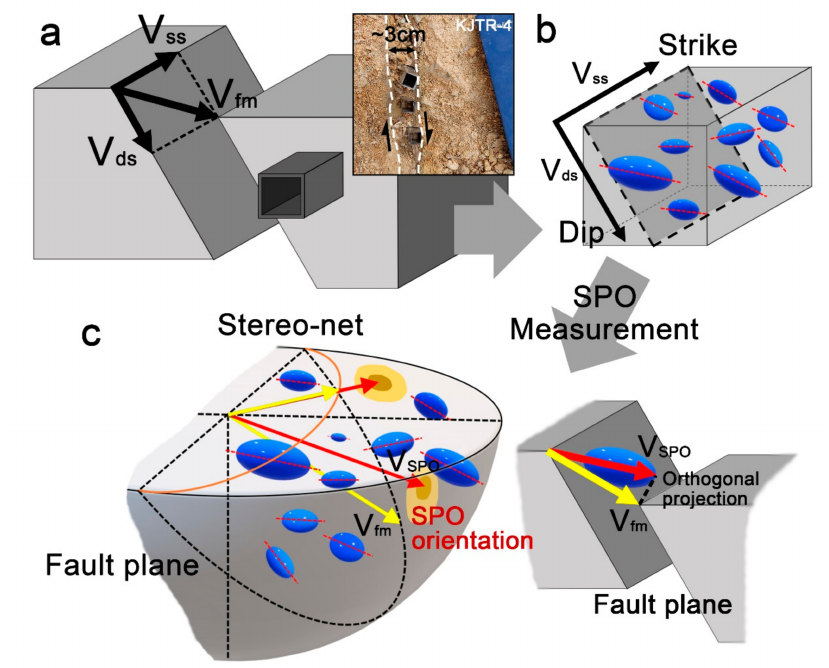
Figure 3. Schematic diagram of the shape preferred orientation (SPO) measurements. ( a ) Schematic diagram showing the fault slip by separating it into strike- and dip-direction vectors; ( b ) The orientations of grains included in the sample obtained through coring are measured through three-dimensional computed tomography (3D-CT) images; ( c ) SPO data representing grain orientations and fault planes are projected onto the stereonet to infer the direction of fault motion (Vfm). V ss , vector of strike-slip; V ds , vector of dip-slip; V fm , vector of fault motion; and V SPO , vector of densest point of